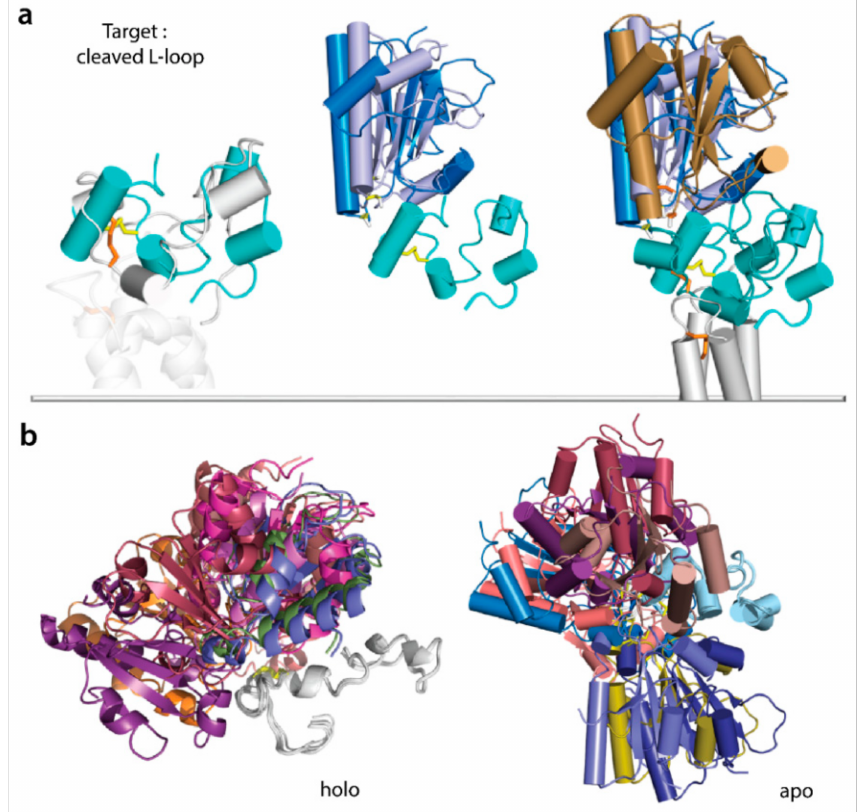
Figure 11. Protein–protein computational docking of PDI (ligand) constant conformation and cleaved L-loop (target) represented by different conformations. Docking was performed by HADDOCK using an information-driven method. ( a ) (left) Superimposition of L-loop cleaved from Model 1 of PDI–hVKORC1 complex at t = 441 ns of cMD simulation (grey) [15] and taken at 4.62 µ s of cMD simulation of cleaved L-loop from apo-h form simulated as an isolated species (teal). (Middle and right) The two best docking solutions obtained for PDI docking onto L-loop conformation with compact (closed) shape superimposed onto L-loop from Model 2 (middle) and on Model 2 (right), suggested as possible in [15]. ( b ) Superimposition of the best solutions obtained for PDI docking onto cleaved L-loop from holo- and apo-forms (X-ray). ( a , b ) Protein is shown as a cartoon with helices as cylinders or spiral and disulfide bridges as yellow